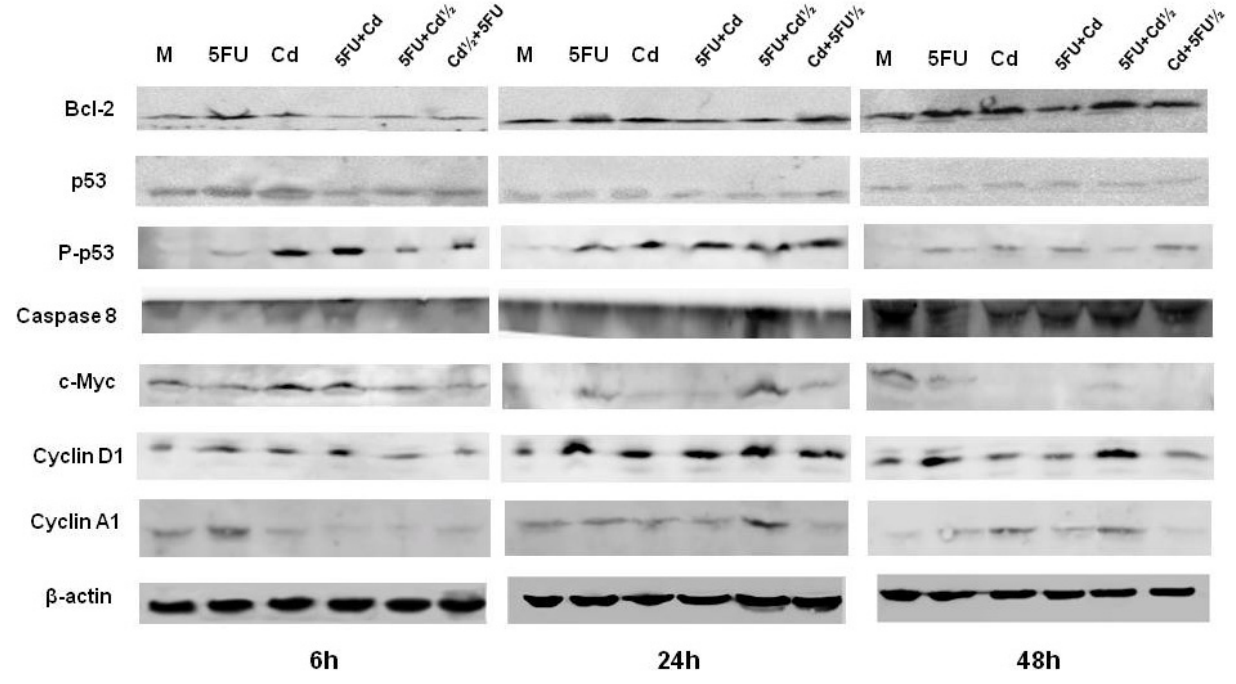
Figure 3. Modification of cell cycle, proliferation and apoptotic proteins analysed by western blot on the MCF-7 cell line after treatment with 5-FU and/or Cd for 6, 24 or 48 h. Representative images of three